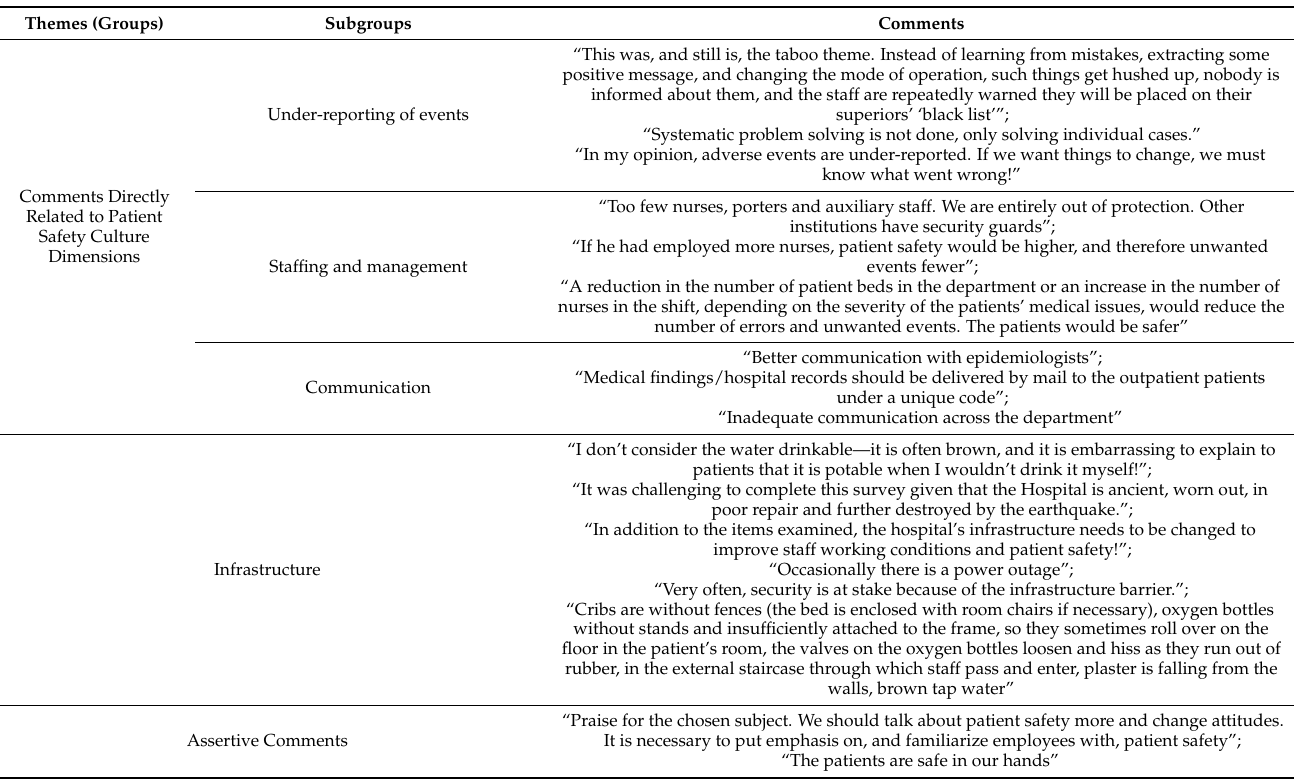
Table 2. Qualitative analysis of the comments sections.